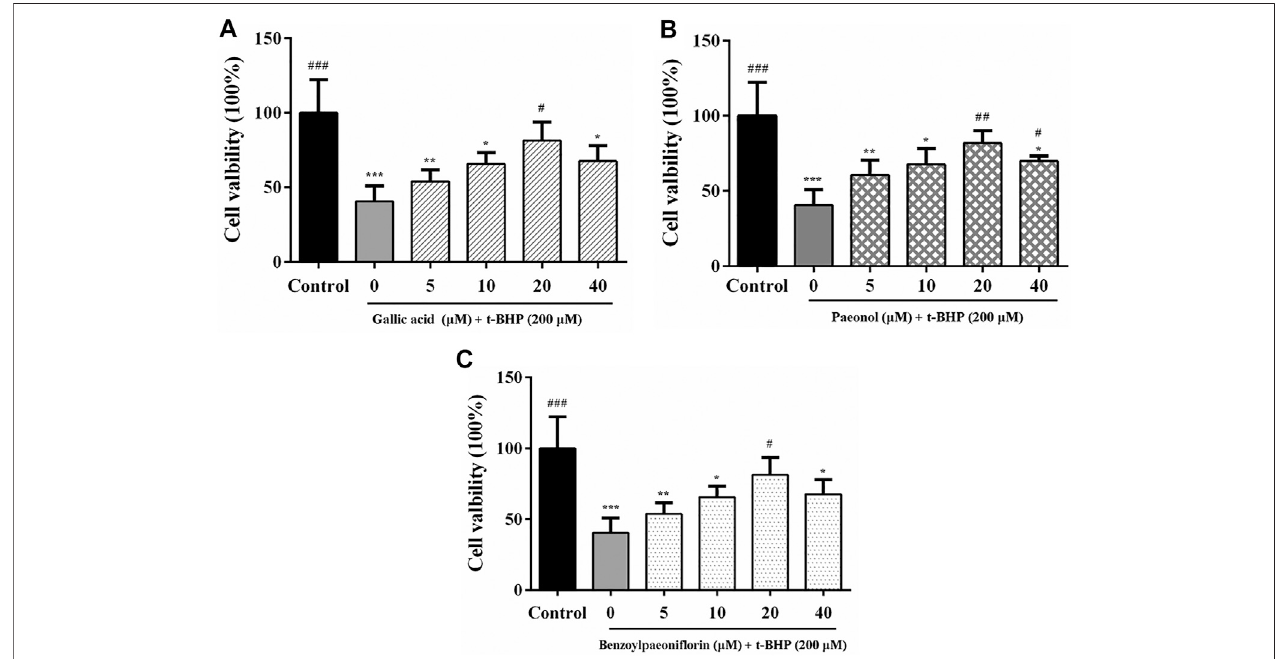
FIGURE6| EvaluationofcellviabilityinRAW264.7withtheMTTassay.Thecomponentsofgallicacid (A) ,paeonol (B) ,andbenzoylpaeoni fl orin (C) showprotective effects in the t-BHP stimulated RAW264.7 cells. Data are given as mean ± standard deviation ( n (cid:2) 6). Compared with t-BHP treatment cell group, ### p < 0.001; ## p < 0.01; ## p < 0.01. Compared with Control, *** p < 0.001; ** p < 0.01; * p < 0.05.